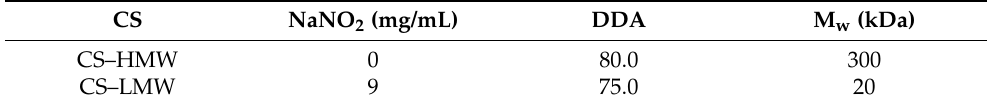
Table 2. DDA and Mw Value of CS–HMW and CS–LMW.